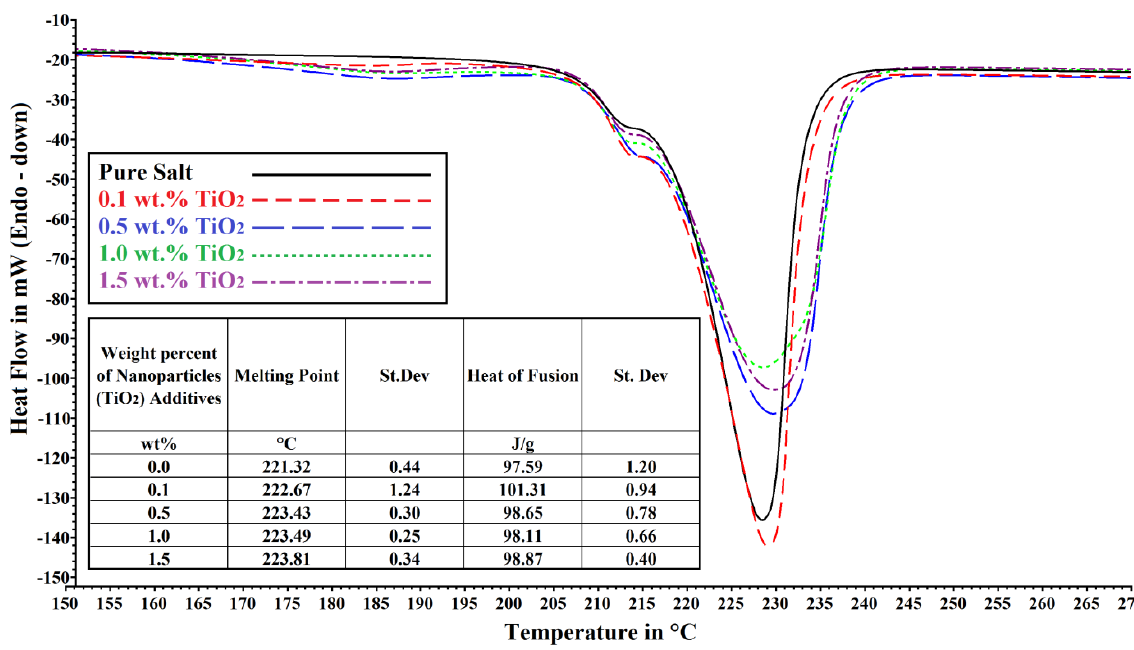
Figure 3. DSC curves of NaNO 3 and KNO 3 eutectic mixture (60/40) with and without TiO 2 nanoparticles. Table inserted in the graph shows the average melting point and heat of fusion